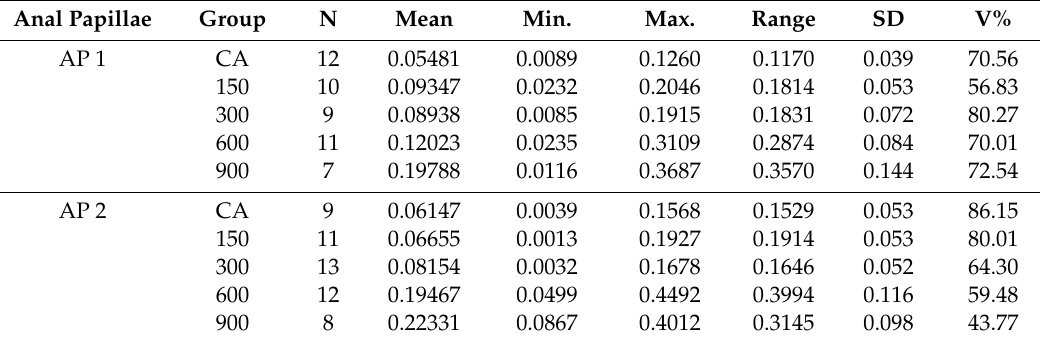
Table 5. Descriptive statistics for FA for the anal papillae of D. melanogaster larvae. Anal Papillae